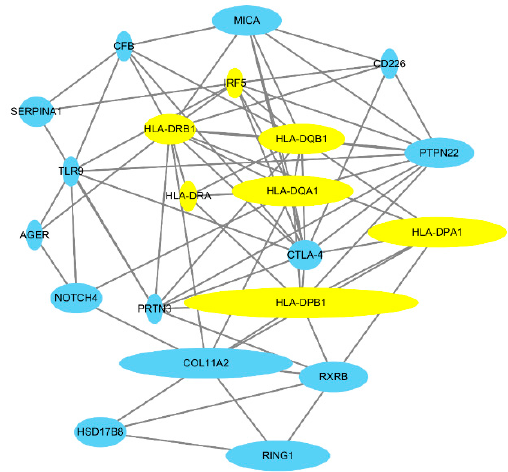
Figure 2. The number of noteworthy SNPs in PR3-ANCA and MPO-ANCA and their protein–protein networks (PPIs). ( A ) The overlap of SNPs in PR3-ANCA and MPO-ANCA; the lack of any shared SNPs between these two subtypes of ANCA-associated vasculitis. ( B ) PPI network of genes associated with PR3-ANCA vasculitis. ( C ) PPI network of genes associated with MPO-ANCA vasculitis. Borderline SNPs (5.0 × 10 − 8 < p < 0.05) from GWASs that have been noteworthy in our analysis were also included. The yellow nodes represent the genes associated with the interferon-gamma-mediated signaling pathway. The number of SNPs associated with PR3-ANCA and MPO-ANCA is 134 and 20, respectively, which leads to a total of 21 and 8 unique genes. Note that some genes have multiple SNPs associated with PR3-ANCA and MPO-ANCA. Among these genes, only 15 genes and 7 genes are included in the PPI network by revealing known PPI interactions in Figures 2B and 2C.